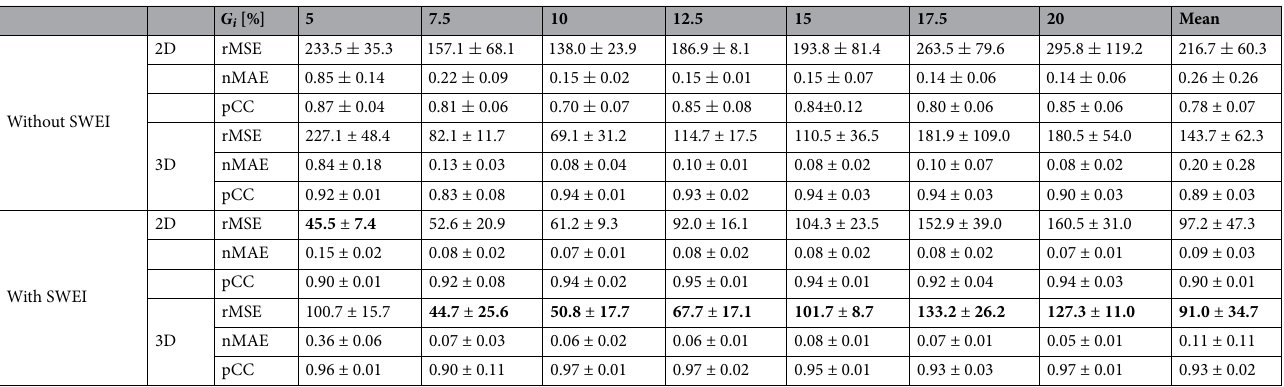
Table 2. Force estimation for models tasked to generalize to unknown elastic properties: Results are compared for 2D and 3D inputs as well as our proposed method with SWEI fusion (2D+SWEI and 3D+SWEI). Mean and standard deviation are given over the 7-fold cross validation where each subset represents the generalization to one unseen elasticity. Results averaged over all folds are also shown and the lowest rMSE [mN] scores are marked in